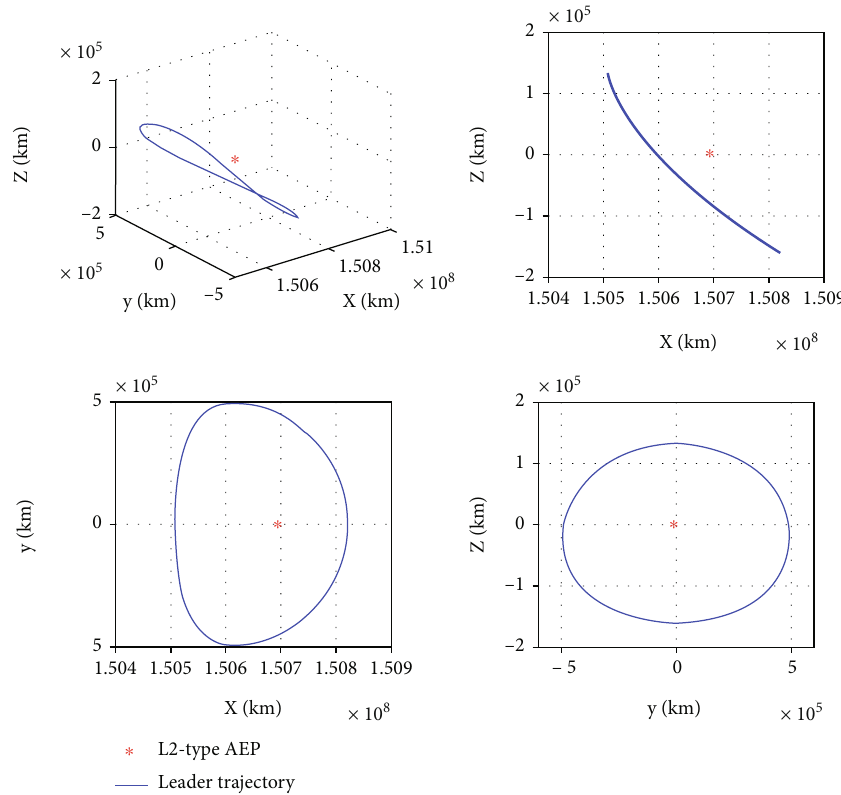
Figure 3: The quasi-halo orbit near L2-type AEP created by the di ff erential corrector.